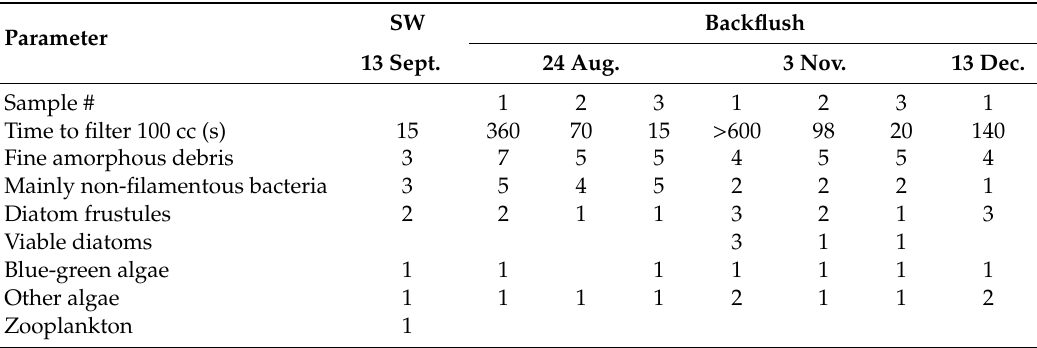
Table 4. Results of microscopic analysis of suspended material in source water (SW) and backflushed water, in 2017. 1–7 = relative abundance low to very high. Samples 1, 2, 3 = after 5, 15 and 30 ‘equivalent’ minutes of pumping. Samples coded 1 (taken after 5 min) correspond with events A, B and C in Table 3. Sample 1 on 3 November shown in Figure 5.